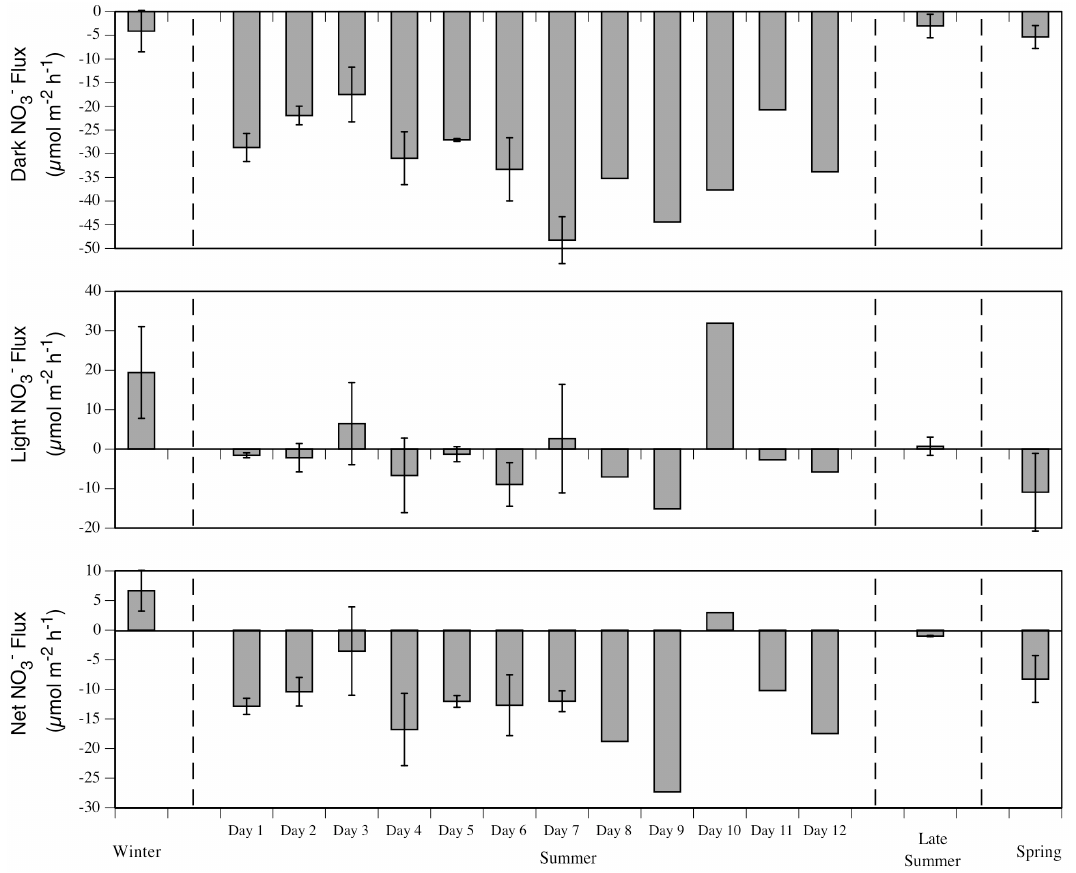
) fluxes (mean ± SE where replicated; see Table 3